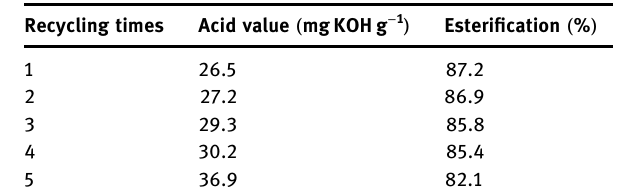
Table 4: Recyclability of catalyst